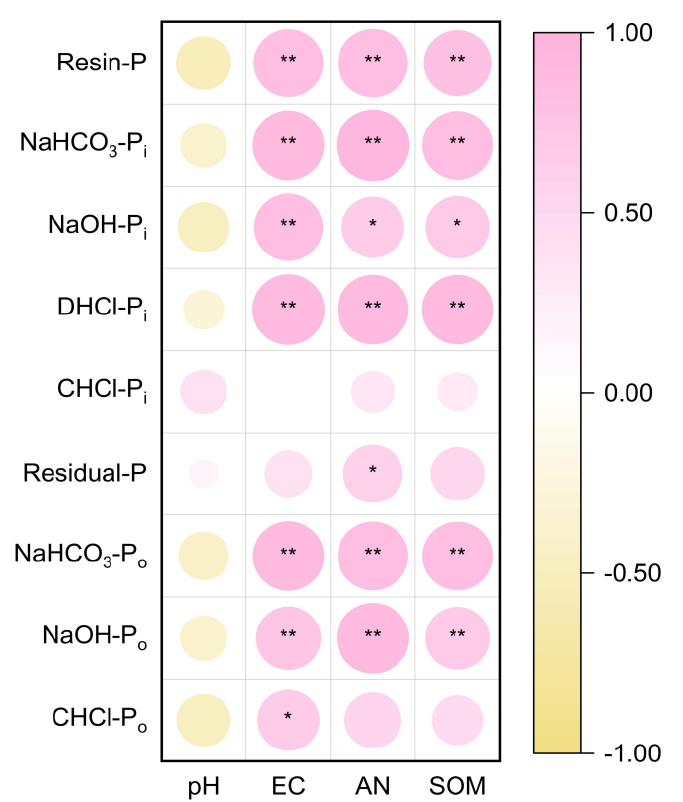
Figure 7. The Pearson correlation analysis for soil chemical properties and P fractions under long-term continuous cropping. The size of the circle indicates the size of the Pearson correlation coefficient, and the larger the circle, the larger the coefficient. EC, electrical conductivity; AN, available nitrogen; and SOM, soil organic matter. * and ** indicate significant correlation at p < 0.05 and 0.01 levels, respectively.